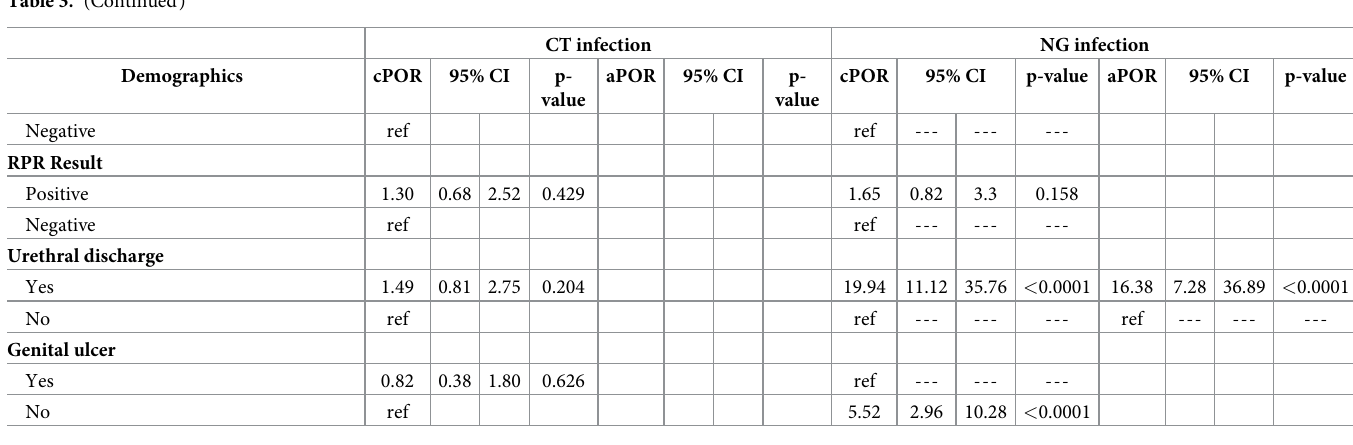
aPOR: Adjusted prevalence odds ratio; cPOR: Crude prevalence odds ratio; RPR: Rapid plasma reagin; CI: Confidence interval; STI: Sexually transmitted disease; NG: Neisseria gonorrhoeae, CT: Chlamydia trachomatis Not significant not shown include: Self-reported symptoms dyspareunia, unpleasant odor, abdominal pain, anal discharge, anal ulcer, anal warts, and sore throat;